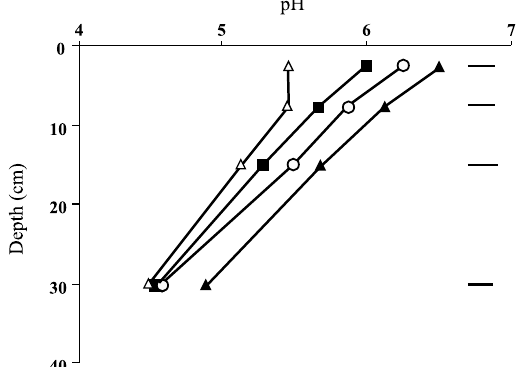
* and **: significant at 5 and 1 % by the F test, respectively; ns: non significant.